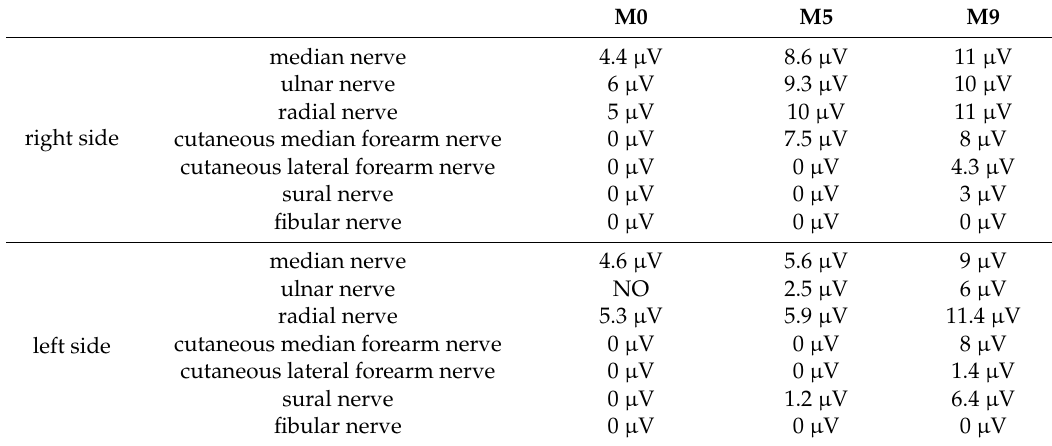
Table 1. Evolution of amplitude of sensory nerve action potential (SNAP) on three successive electrophysiological studies of sensory nerves: initial study (M0) before treatment, second study five months after (M5), then third study nine months after the vitamin B12 treatment initiation